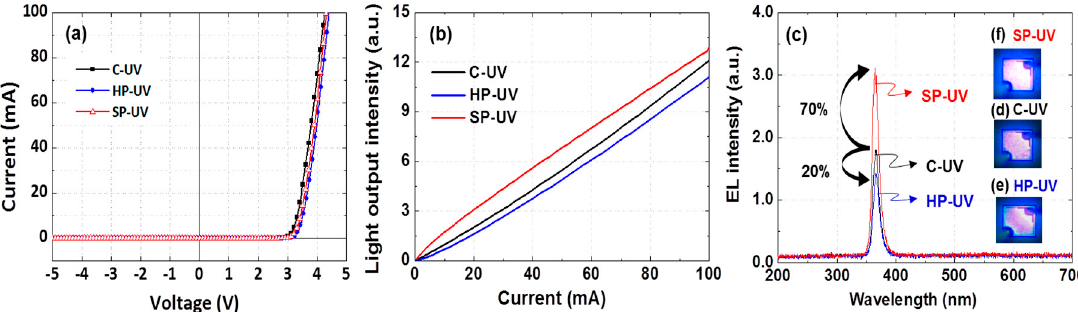
Figure 5. PL results of UV emitters with different sizes Pt NPs.